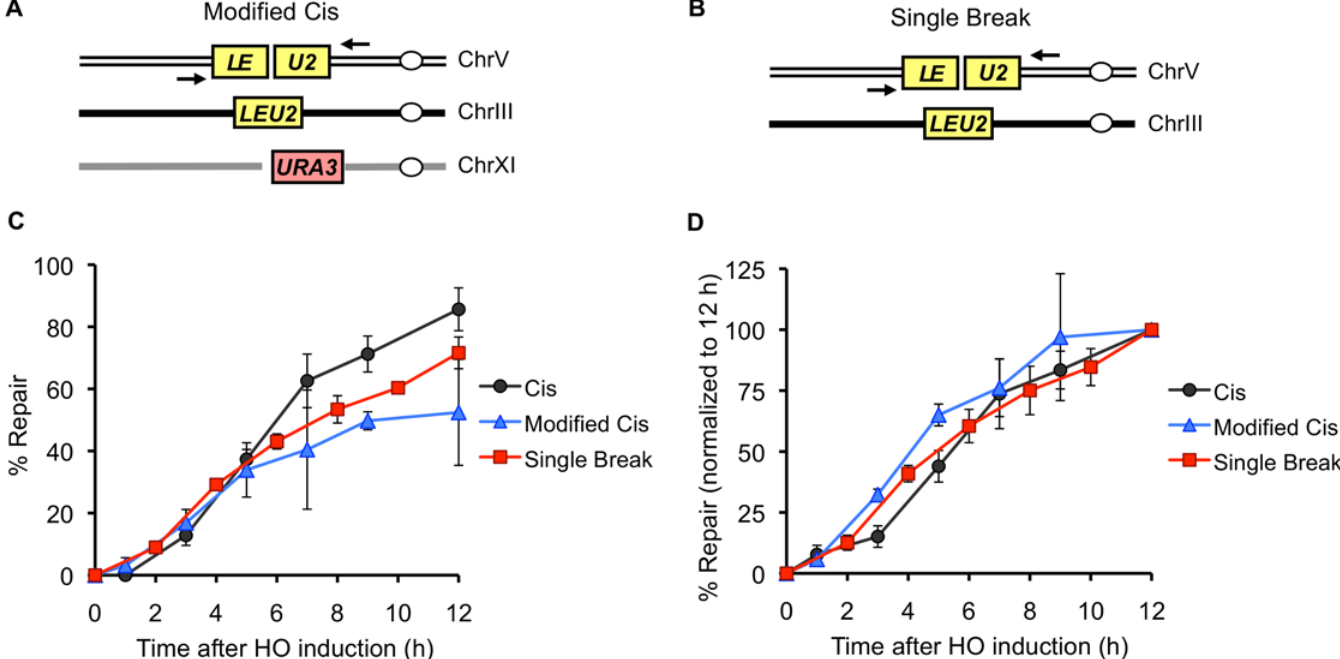
Fig 3. The kinetics of LEU2 repair are independent of the repair outcome of another break. (A) Schematic representation of a modified Cis strain, tNS2607, which carries an LE-HOcs-U2 cassette at the can1 locus on Chr V, a LEU2 donor on Chr III and an unrepairable HOcs-URA3 break (instead of a ura3-HOcs-URA3 cassette) on Chr XI. (B) Schematic representation of a strain which carries a LE-HOcs-U2 cassette at the can1 locus on Chr V and a LEU2 donor on Chr III (YSJ119 [13]). This strain harbors a single HO break. (C) Kinetics of LEU2 repair in the indicated strains, as determined by a quantitative PCR assay using primers shown schematically (black arrows) in Figs 1(B) and 3(A) and 3(B). The amount of PCR product obtained from a repaired colony was used to make the standard curve for quantification. (D) Data from (C) plotted after normalizing the amount of PCR product obtained at 12h time point for each strain to 100%. For Cis and Single Break, data represent mean of a total of 6 PCR reactions from two independent time courses ± S.D. For Modified Cis, data represent mean of three independent time courses ± S.D. The Single Break data shown in (C) has been published in [13].